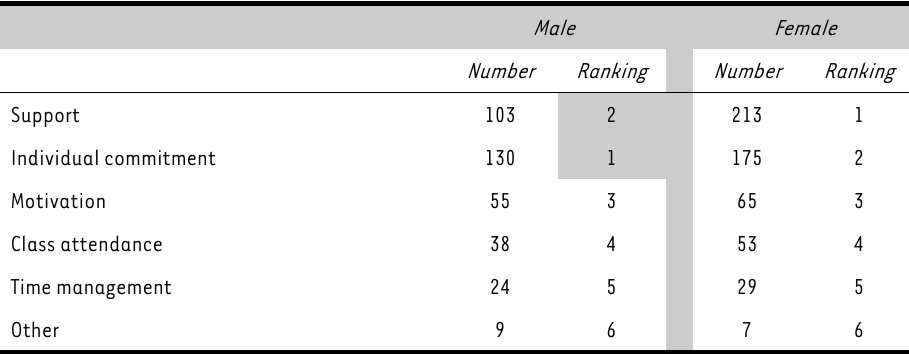
Factors promoting own success split between genders